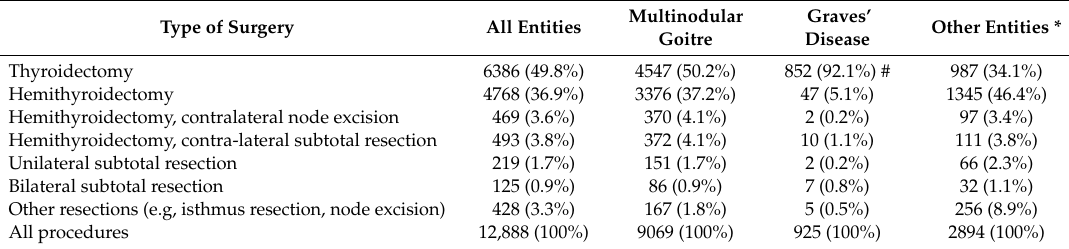
Table 3. Extent of thyroid resections according to